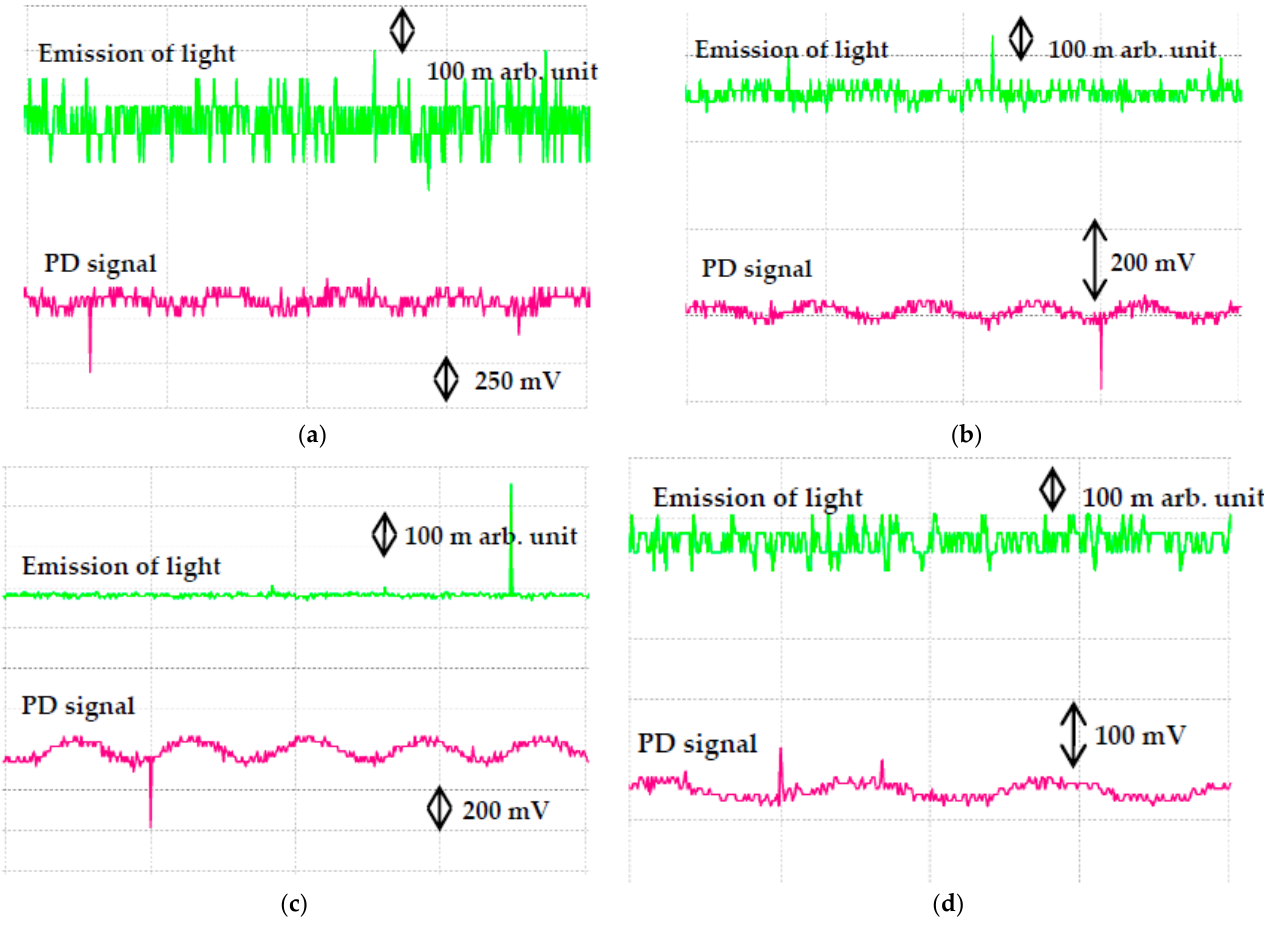
Figure 12. Emission of light signals (PMT) and PD signals (IMC) for ( a ) RBDPOA, ( b ) RBDPOB, ( c ) CO and ( d ) MO based Al 2 O 3 with SDS at 30 kV applied voltage.